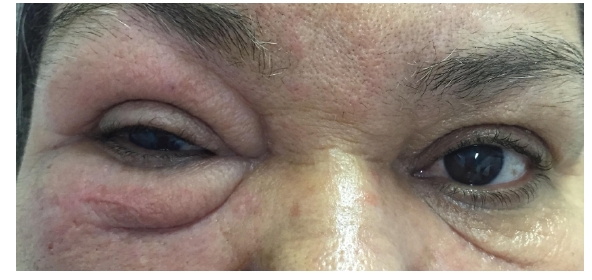
Figure 1: Eyelid edema at the right side At biomicroscopy, bilateral blepharitis associated with local hyperemia and soft eyelid edema at the right eye was noticed, without any other abnormalities. The pa- tient’s best corrected visual acuity was 20/20 in both eyes. Intraocular pressure (IOP) was also normal, and fundoscopy revealed narrow arteriolar and pathological arteriovenous crossings, compatible to hypertensive ret- inopathy.